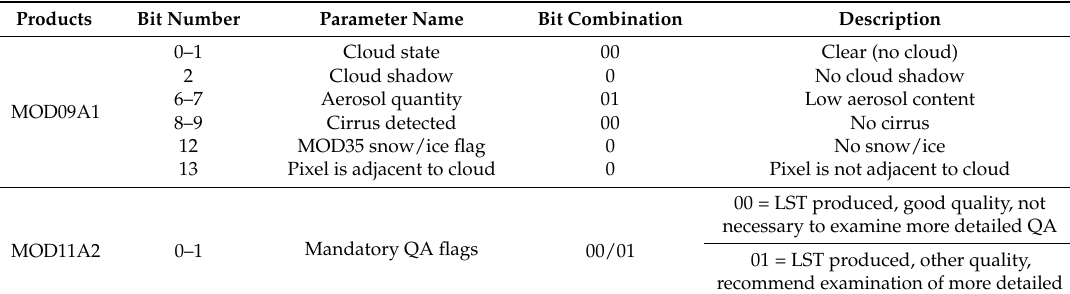
Table 1. Quality control standards of MOD09A1 and